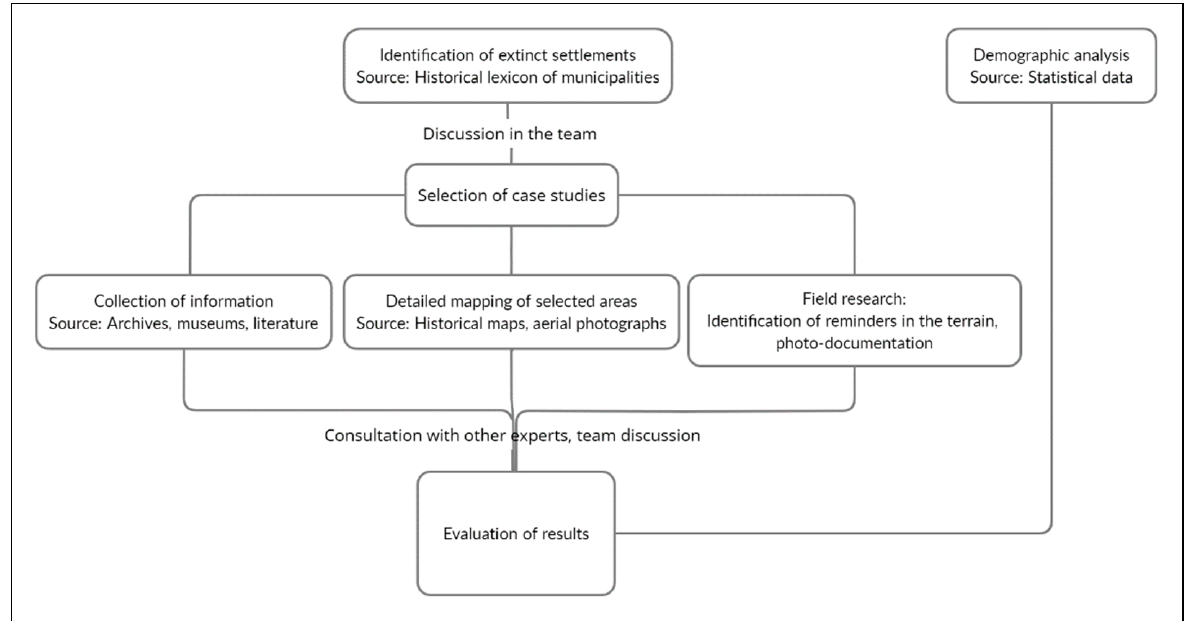
Figure 1. Research